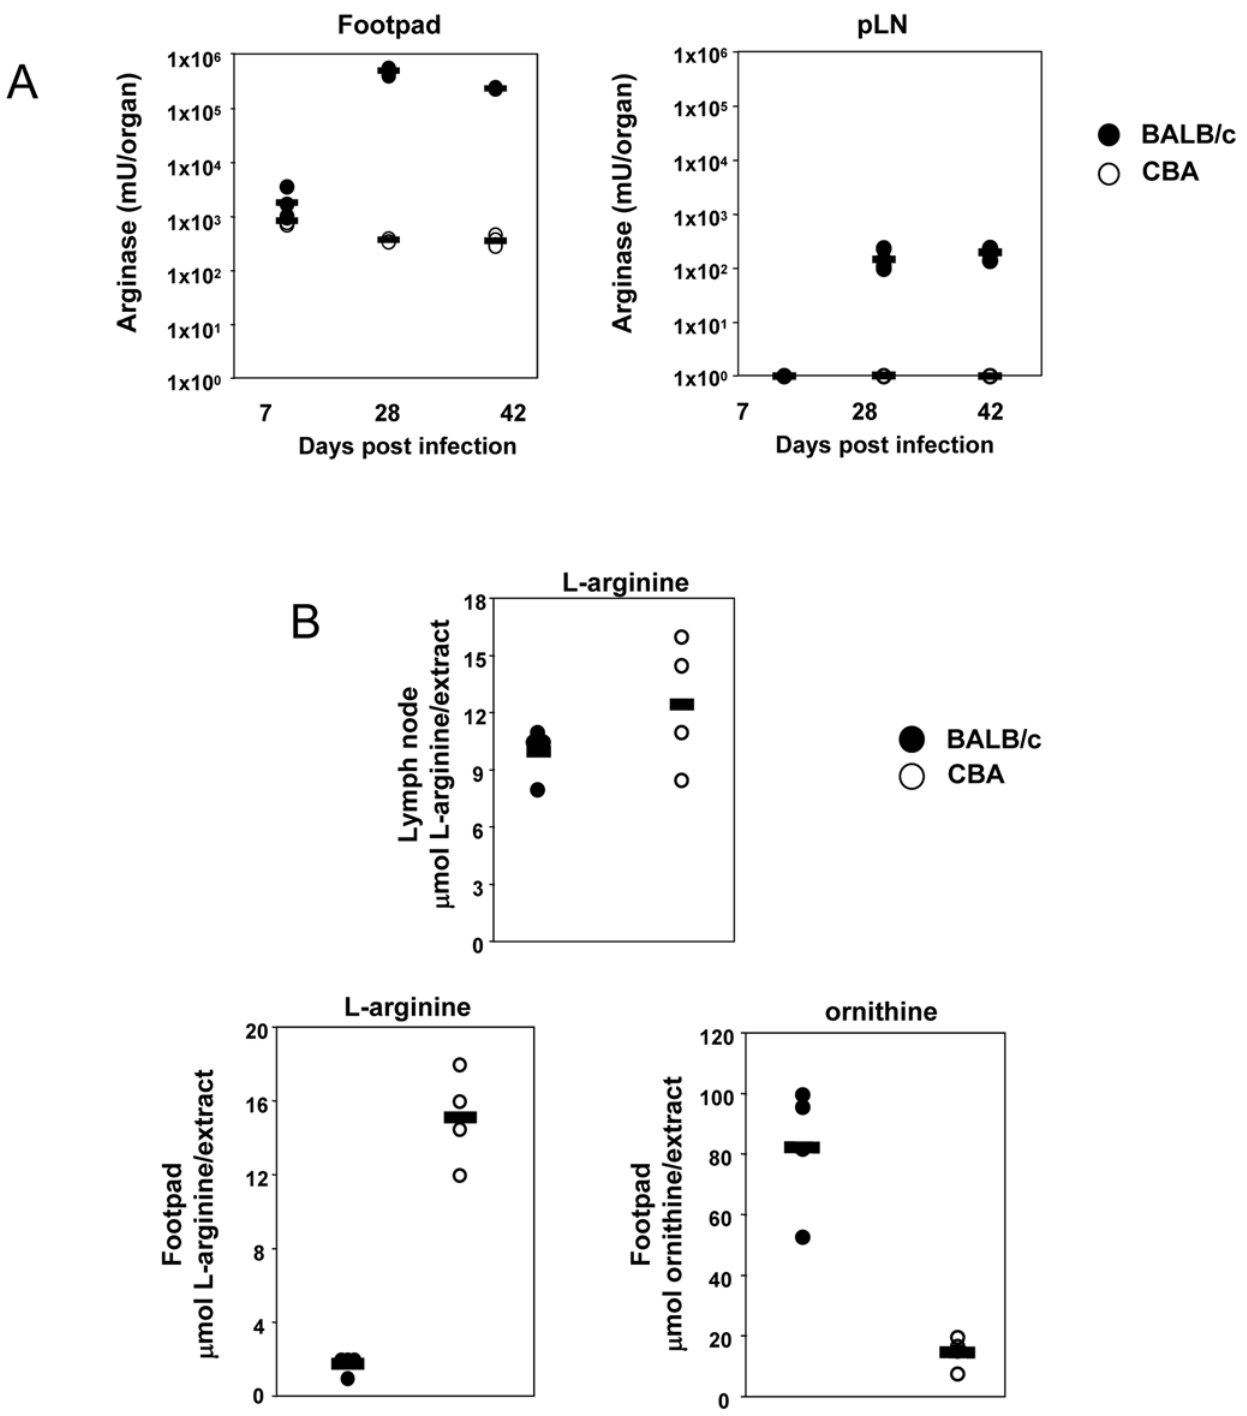
Figure 1. High arginase activity is localised at the site of pathology and results in reduced levels of L-arginine at the site of pathology. (A) Groups of BALB/c and CBA mice (n=4) were infected with L. major parasites in one hind footpad and 1, 4 and 6 weeks post infection, individual footpads and popliteal lymph nodes were harvested and arginase activity was determined by enzymatic assay. Each symbol represents arginase activity for one individual organ, the horizontal line representing the average value. Data show the results of one representative experiment out of five independent experiments. (B) Groups of BALB/c and CBA mice (n=4) were infected with L. major parasites in one hind footpad and 4 weeks post infection, individual footpads and popliteal lymph nodes were harvested and levels of extracellular L-arginine were determined using an amino acid analyser. Data show the results of one representative experiment out of two independent experiments.